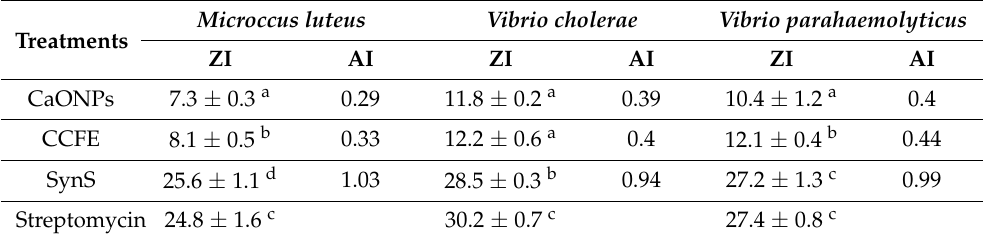
Table 2. Antimicrobial activity of CaONPs, C. colocynthis fruit extracts, and their synergistic solution. Treatments